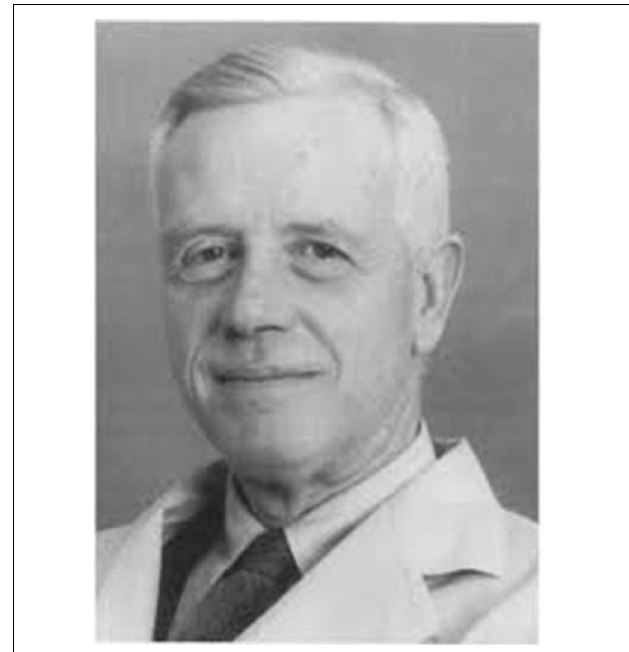
FIGURE 1 | Photograph of Dr. Eaton Eaton, Monroe D., U.S. microbiologist, 1904–1958. The photograph of Dr. Eaton in the manuscript ( Rev Infect Dis, 12, 338–353), which taken in the early 1960s and reprinted permission was